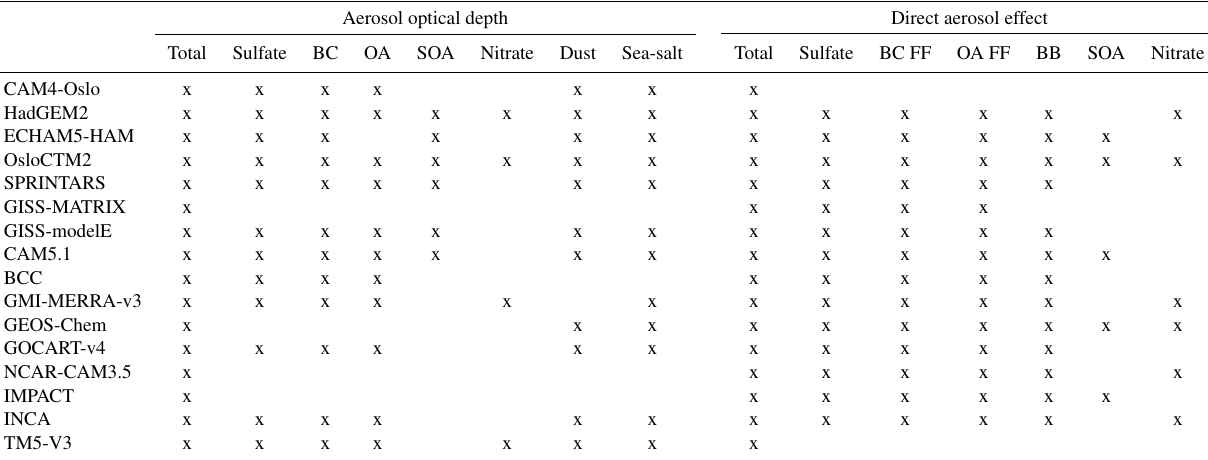
Table 1. List of the models used in this study and which species they have reported.